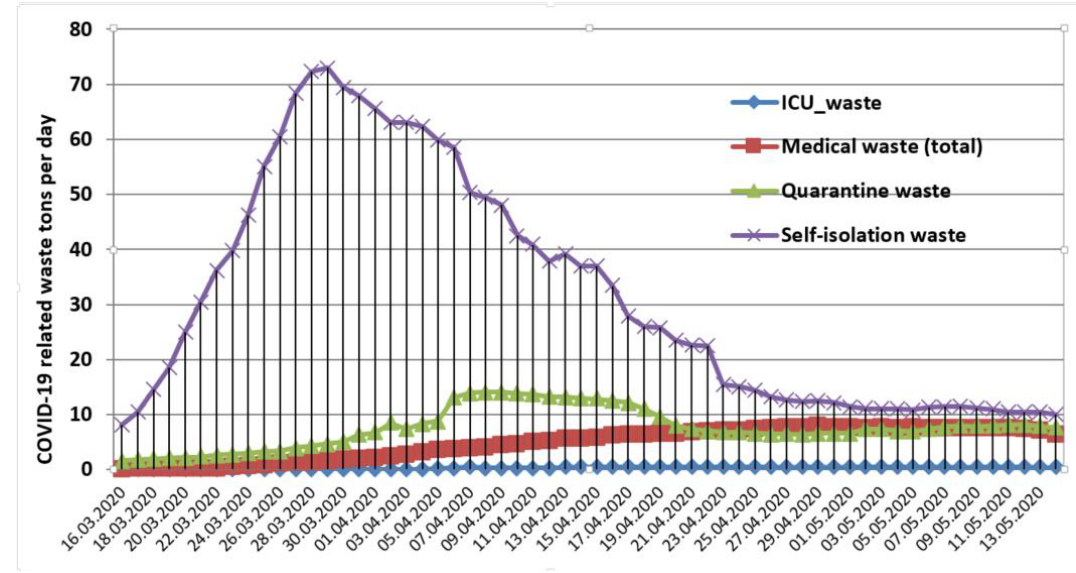
Figure 1. COVID-19 related waste flow in Romania during the emergency state.